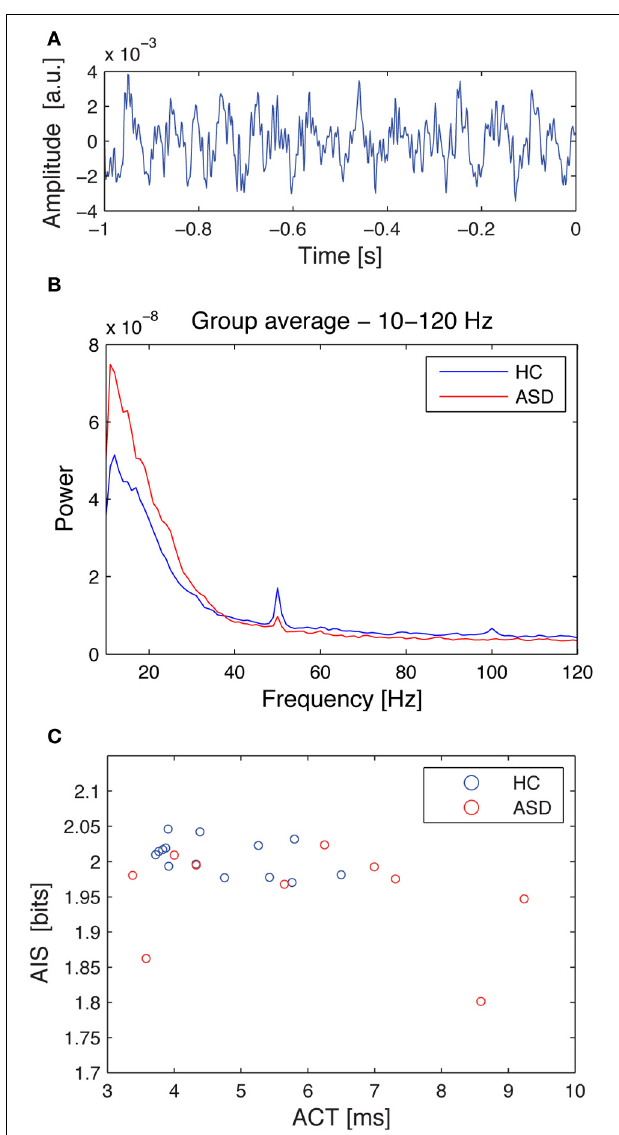
FIGURE 4 | Source time courses, power spectra and the correlation of autocorrelation decay constant, and AIS for the hippocampal source. (A) Exemplary dipole moment time course of a single trial (baseline) for the hippocampal source. (B) Source spectral power for the hippocampal source, separately averaged for the healthy controls (HC, blue), and the ASD patients (ASD, red). Note that the spectrum was cut at 10Hz as this was the lowest frequency included in the AIS analysis. (C) Correlation plot between the autocorrelation decay time (ACT) and the AIS. Data are shown separately for healthy controls (HC, blue), and the ASD patients (ASD, red). See Table 1 for details on correlation coefficients.